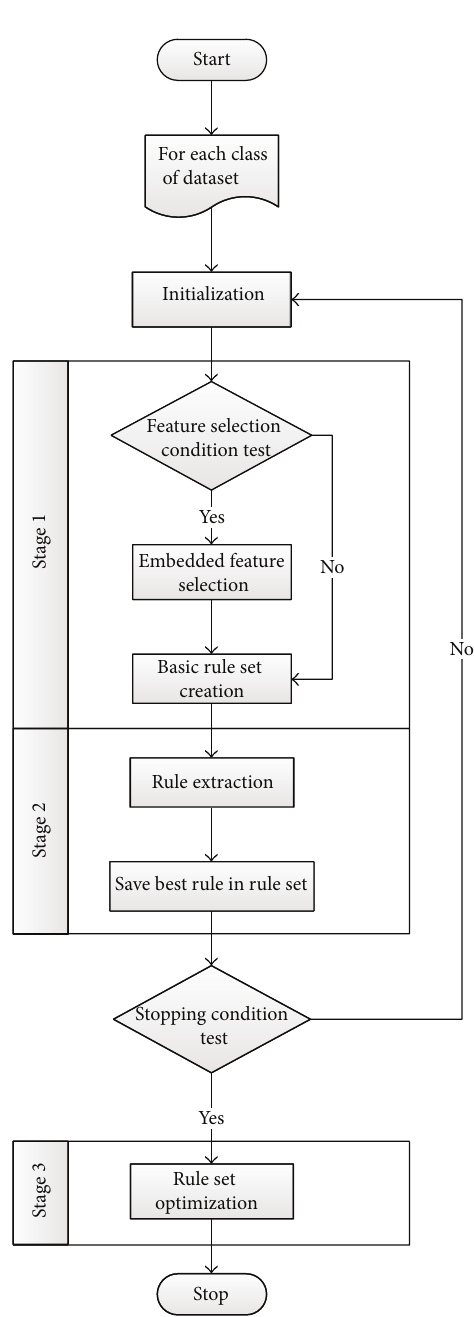
Figure 2: Proposed algorithm